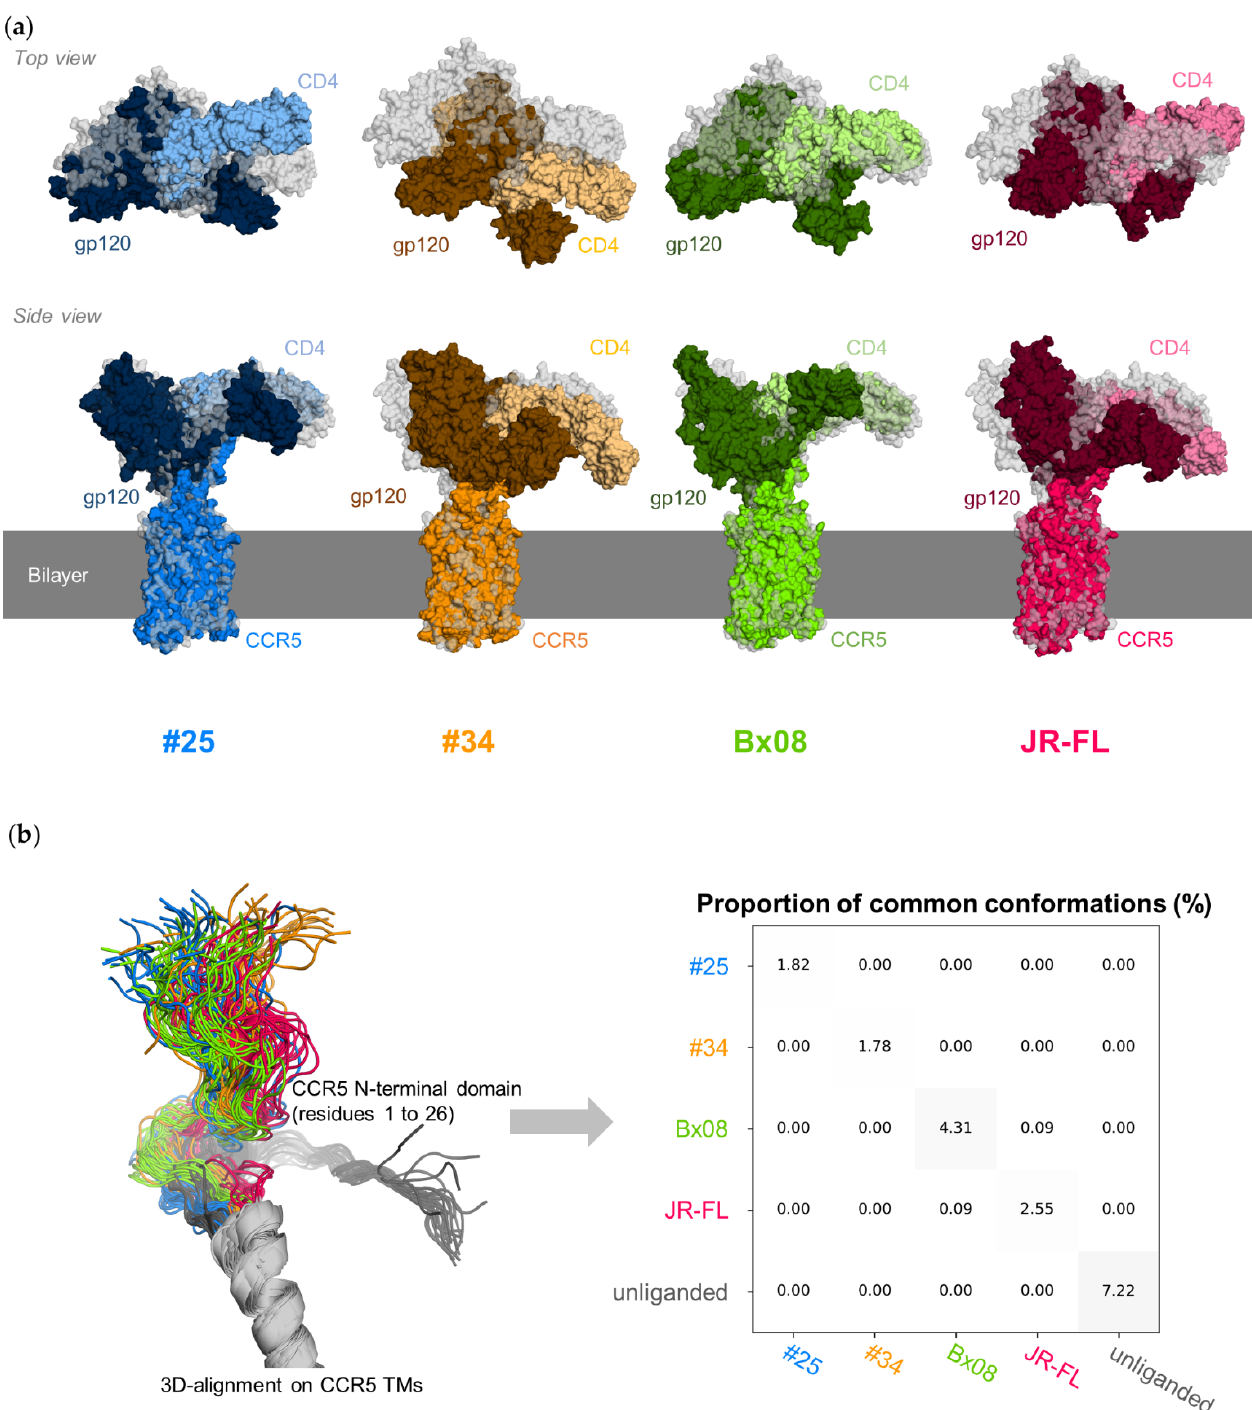
Figure 2. Overall structure of CD4–gp120–CCR5 complexes. The gp120 variants are colored as follows: #25 in blue, #34 in orange, Bx08 in green and JR-FL in red. All structures were 3D aligned onto CCR5 transmembrane residues: ( a ) last structure of a trajectory. CCR5, gp120 and CD4 are represented by molecular surfaces, colored using normal, dark and light tones, respectively. For the sake of comparison, the cryo-EM structure (PDB ID: 6MEO) is represented too, in grey; ( b ) diversity of the positioning of the N-terminal domain of CCR5 with respect to the TM inserted into the lipid bilayer. The N-terminal domain of ligand-free CCR5 is shown in grey. The proportion of common conformations is computed from the all-against-all comparison of one in ten snapshots issued from the simulation of the same complex (diagonal of the matrix) or the systematic pairwise comparison of one in ten snapshots issued during the simulation of two different complexes (off-diagonal terms of the matrix). The N-terminal conformation is common to two snapshots whether the deviation of the N-terminal C α coordinates is low (RMSD < 2 Å).